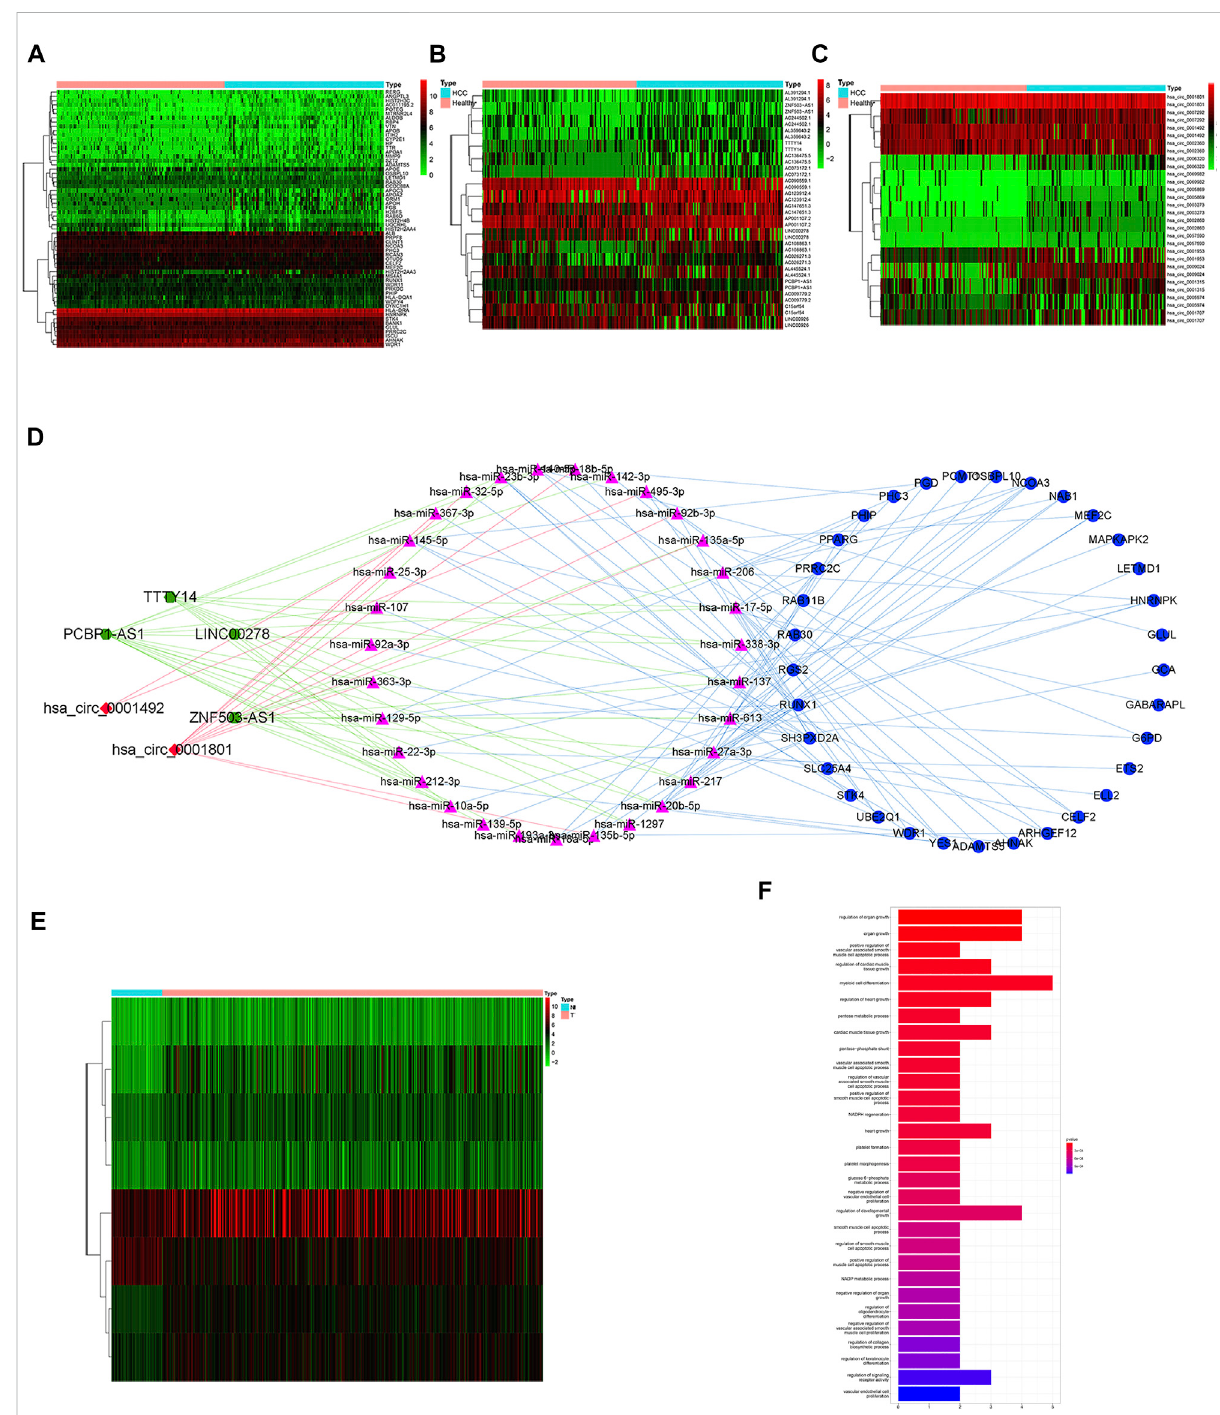
FIGURE 1 Identi fi cation of differential exosomes-related genes (A) heatmap of differentially expressed mRNAs between HCC patients and healthy individuals. (B) heatmap of differentially expressed lncRNAs between HCC patients and healthy individuals. (C) heatmap of differentially expressed circRNAs between HCC patients and healthy individuals. (D) ceRNA network; Green hexagon nodes represent lncRNAs, red diamond nodes represent circRNAs, red triangle nodes represent miRNAs, and blue round nodes represent mRNAs. (E) heatmap of differentially expressed exosomes-relatedmRNAsfromceRNAnetworkbetweenHCCtissuesandadjacentnormaltissues. (F)